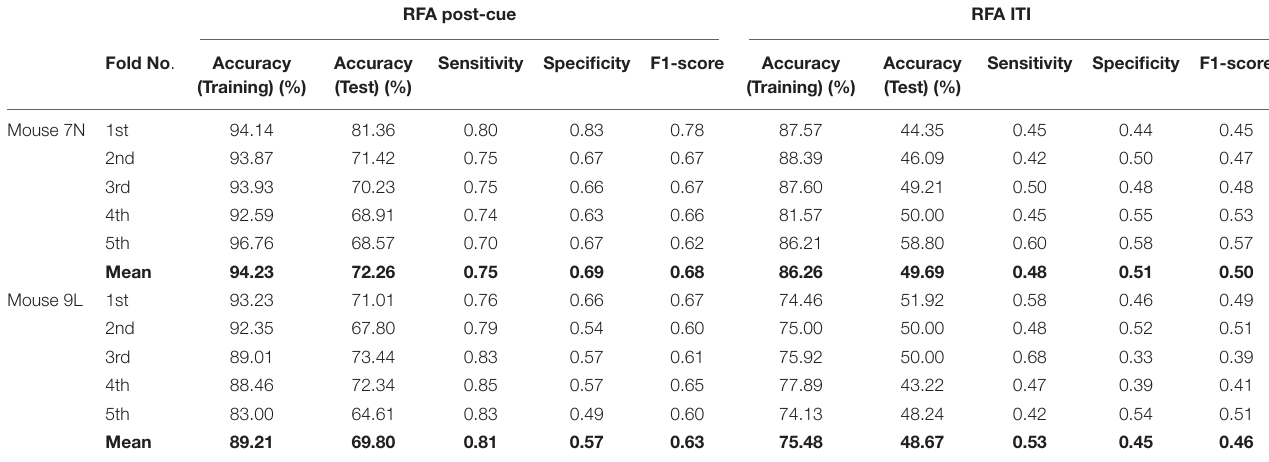
Bold values indicate data group names, performance matrices and mean results of five-fold cross